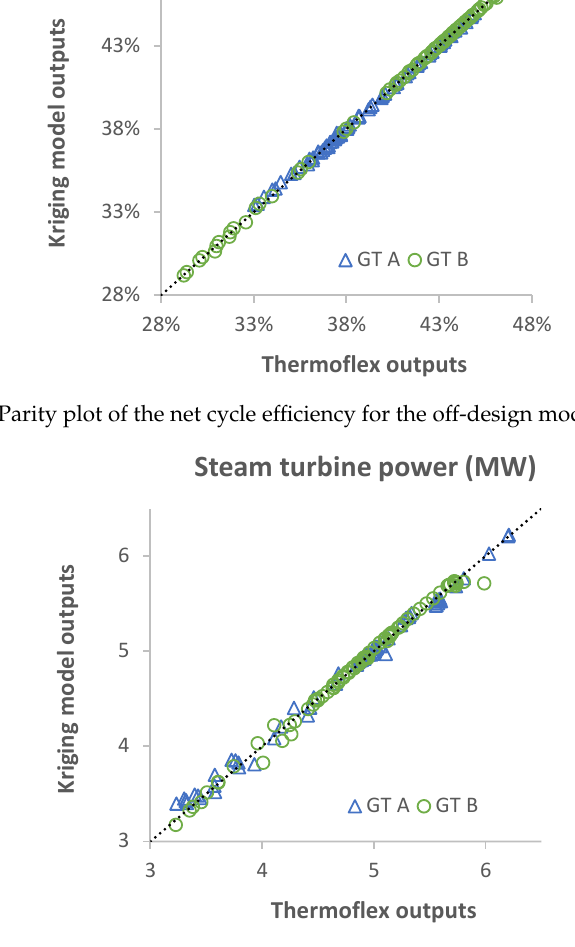
Figure A7. Parity plot of the steam flow rate for the off-design model validation.